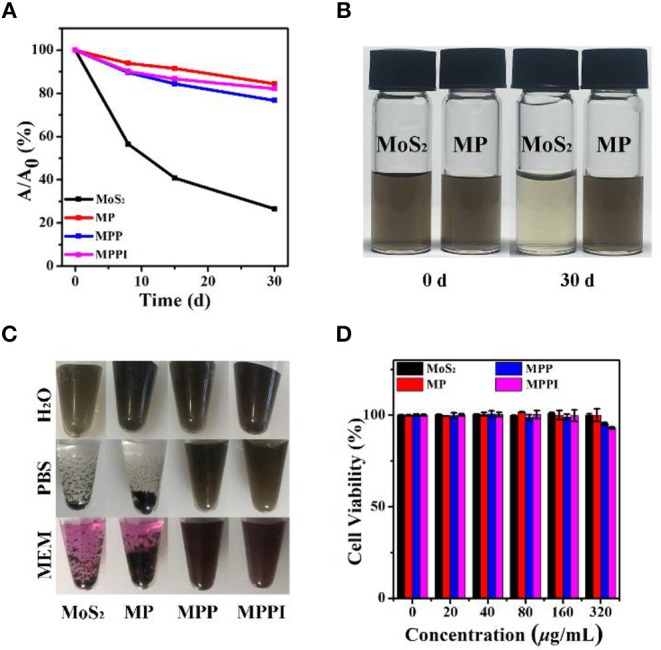
(A) The relative absorbance at 785 nm of MoS2 NSs, MP NSs, MPP NSs, and MPPI NSs aqueous dispersions (MoS2: 20 μg/mL) after stored in ambient environment at different times. (B) Photographs of MoS2 NSs and MP NSs aqueous dispersions (MoS2: 20 μg/mL) at 0 d and 30 d. (C) Photographs of MoS2 NSs, MP NSs, MPP NSs, and MPPI NSs (MoS2: 40 μg/mL) dispersed in H2O, PBS (phosphate buffered saline), and MEM (Minimum Essential Medium) for 1 d, respectively. (D) Cell viabilities of human cervical carcinoma (HeLa) cells after incubation with MoS2 NSs, MP NSs, MPP NSs, and MPPI NSs for 24 h.